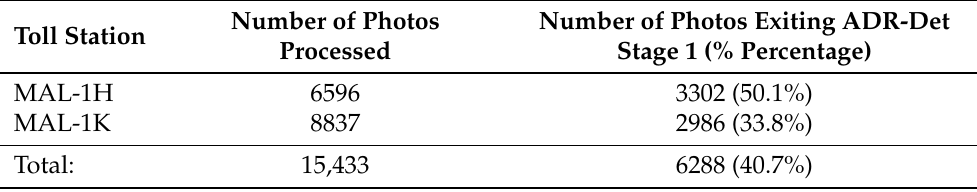
Table 2. Results of the validation process of the 1st stage of ADR-Det algorithm, during March 2021, using two toll posts input